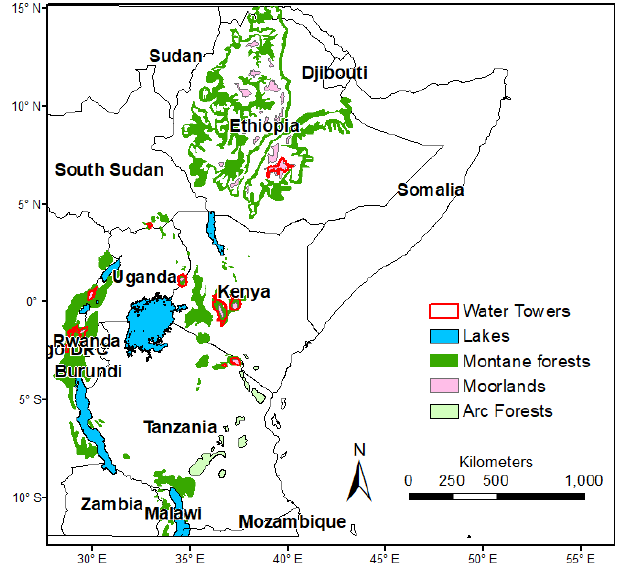
Figure 1. The East African forest ecosystems and the location of the selected water towers (adapted from The Nature Conservancy,